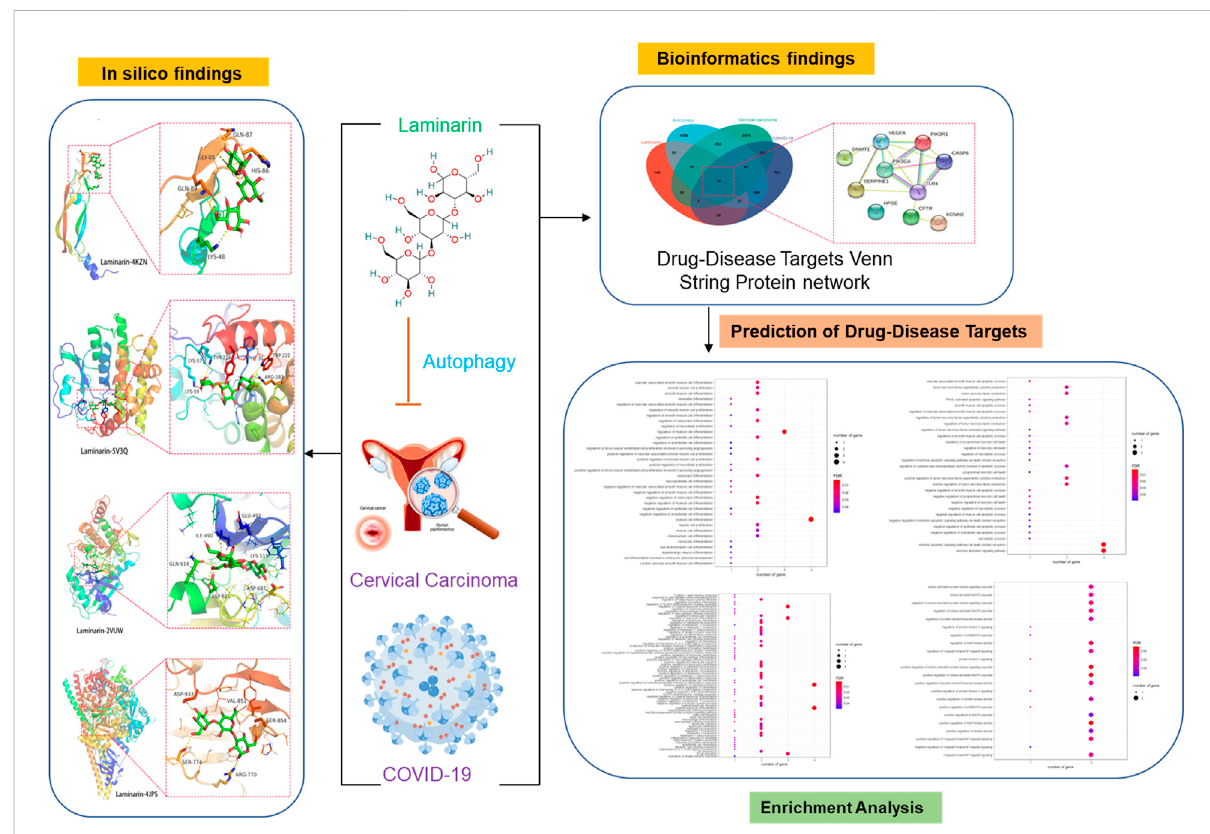
FIGURE 5 Work fl ow of the study. The pharmaceutic targets and their function roles were identi fi ed using network pharmacology, gene ontology enrichment analysis, and molecular